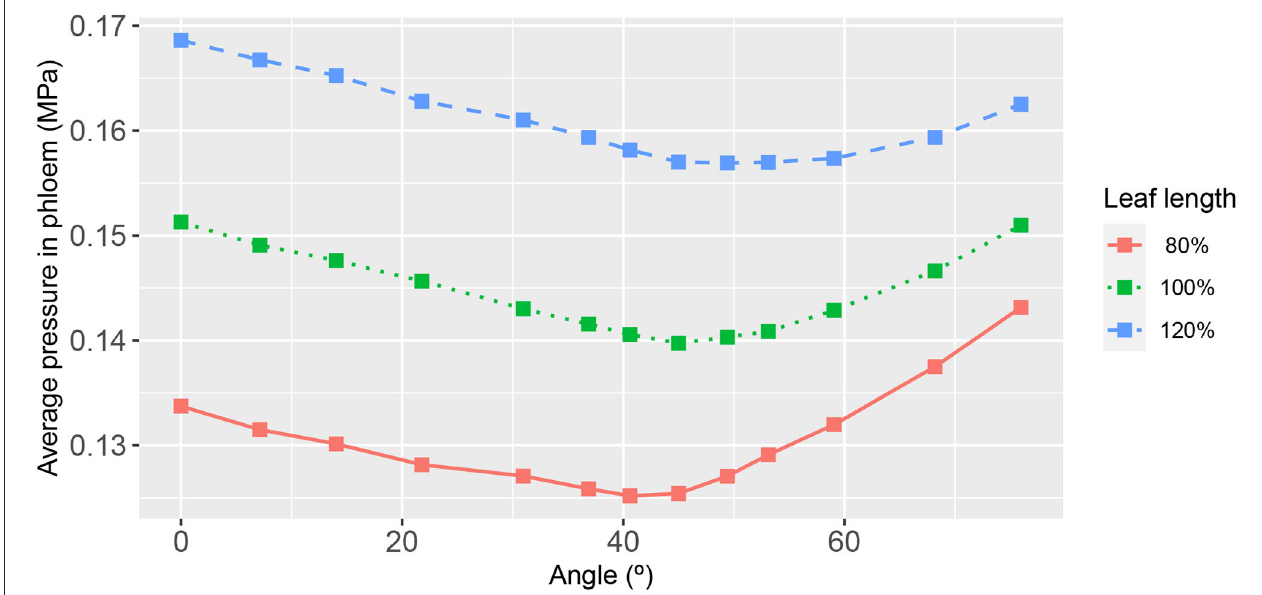
FIGURE 8 | The functional relationship between leaf area-average, hydraulic pressure in the phloem, and second-order vein angle. Curve descriptions and simulation conditions are as in Figure 3 .